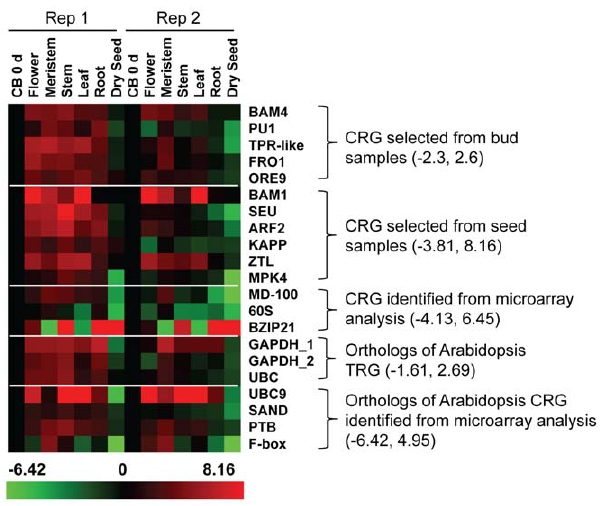
Figure 3. Candidate reference genes examined in different plant organs. Two sets of plant organ samples (Rep1 and Rep2) were used to examine gene expression. The fold difference is designated as log2 value. Red indicates up-regulated genes and green indicates down-regulated genes as compared with non-induced crown buds (CB 0 d, black). Bars at the bottom indicate the range of transcript changes in log2 value. The range of transcript changes is also shown inside the parenthesis. CRG: Candidate Reference Genes. TRG: Traditional Refer- ence Genes.